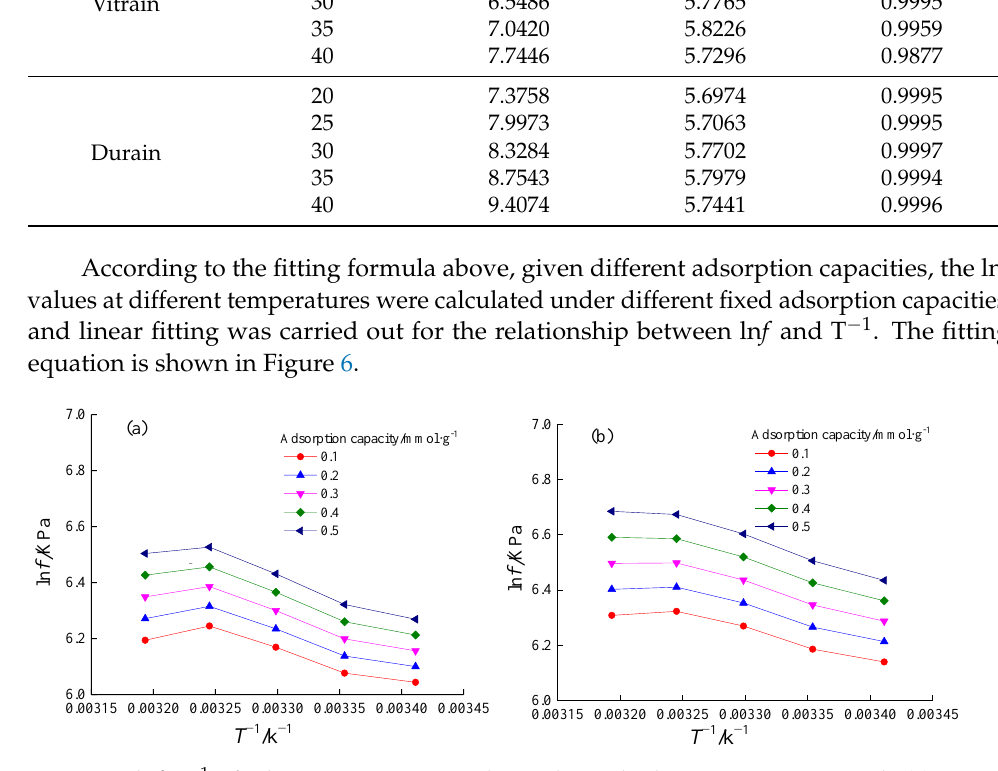
Figure 6. ln f -T − 1 of adsorption process in the isothermal adsorption experimental: ( a ) vitrain; ( b ) durain.